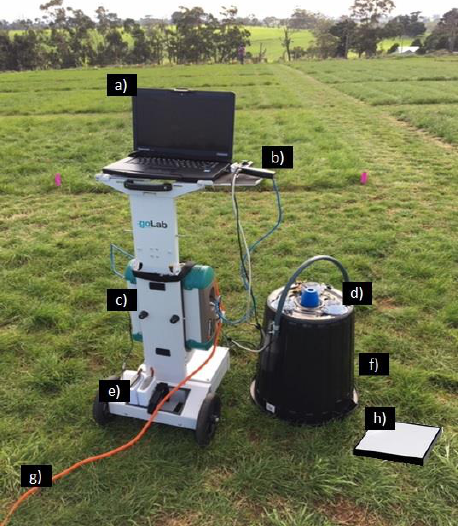
Figure 2. The ASD FieldSpec ® HiRes 4 spectroradiometer setup for spectra collection in field conditions. ( a ) Field laptop; ( b ) 10° lens, scrambler, and pistol-grip; ( c ) the FieldSpec ® Hi-Res 4; ( d ) halogen lights; ( e ) energy supply for the spectroradiometer; ( f ) light-shield; ( g ) power supply to the light-shield; and ( h ) Spectralon ® reference panel.